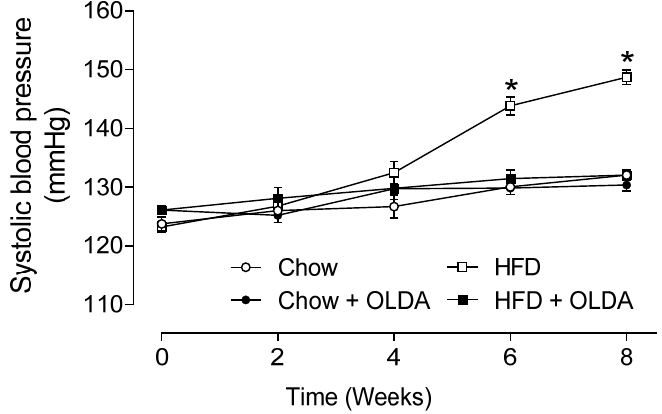
Figure 5. Effects of OLDA on systolic blood pressure. Tail-cuff systolic blood pressure in chow-fed or high-fat-diet (HFD)-fed rats during 8 week of treatment with or without intrathecal N-oleoyldopamine (OLDA) treatment (1 ng/kg, daily). Values are means ± SE (n = 8). * p < 0.05 compared with that of the chow